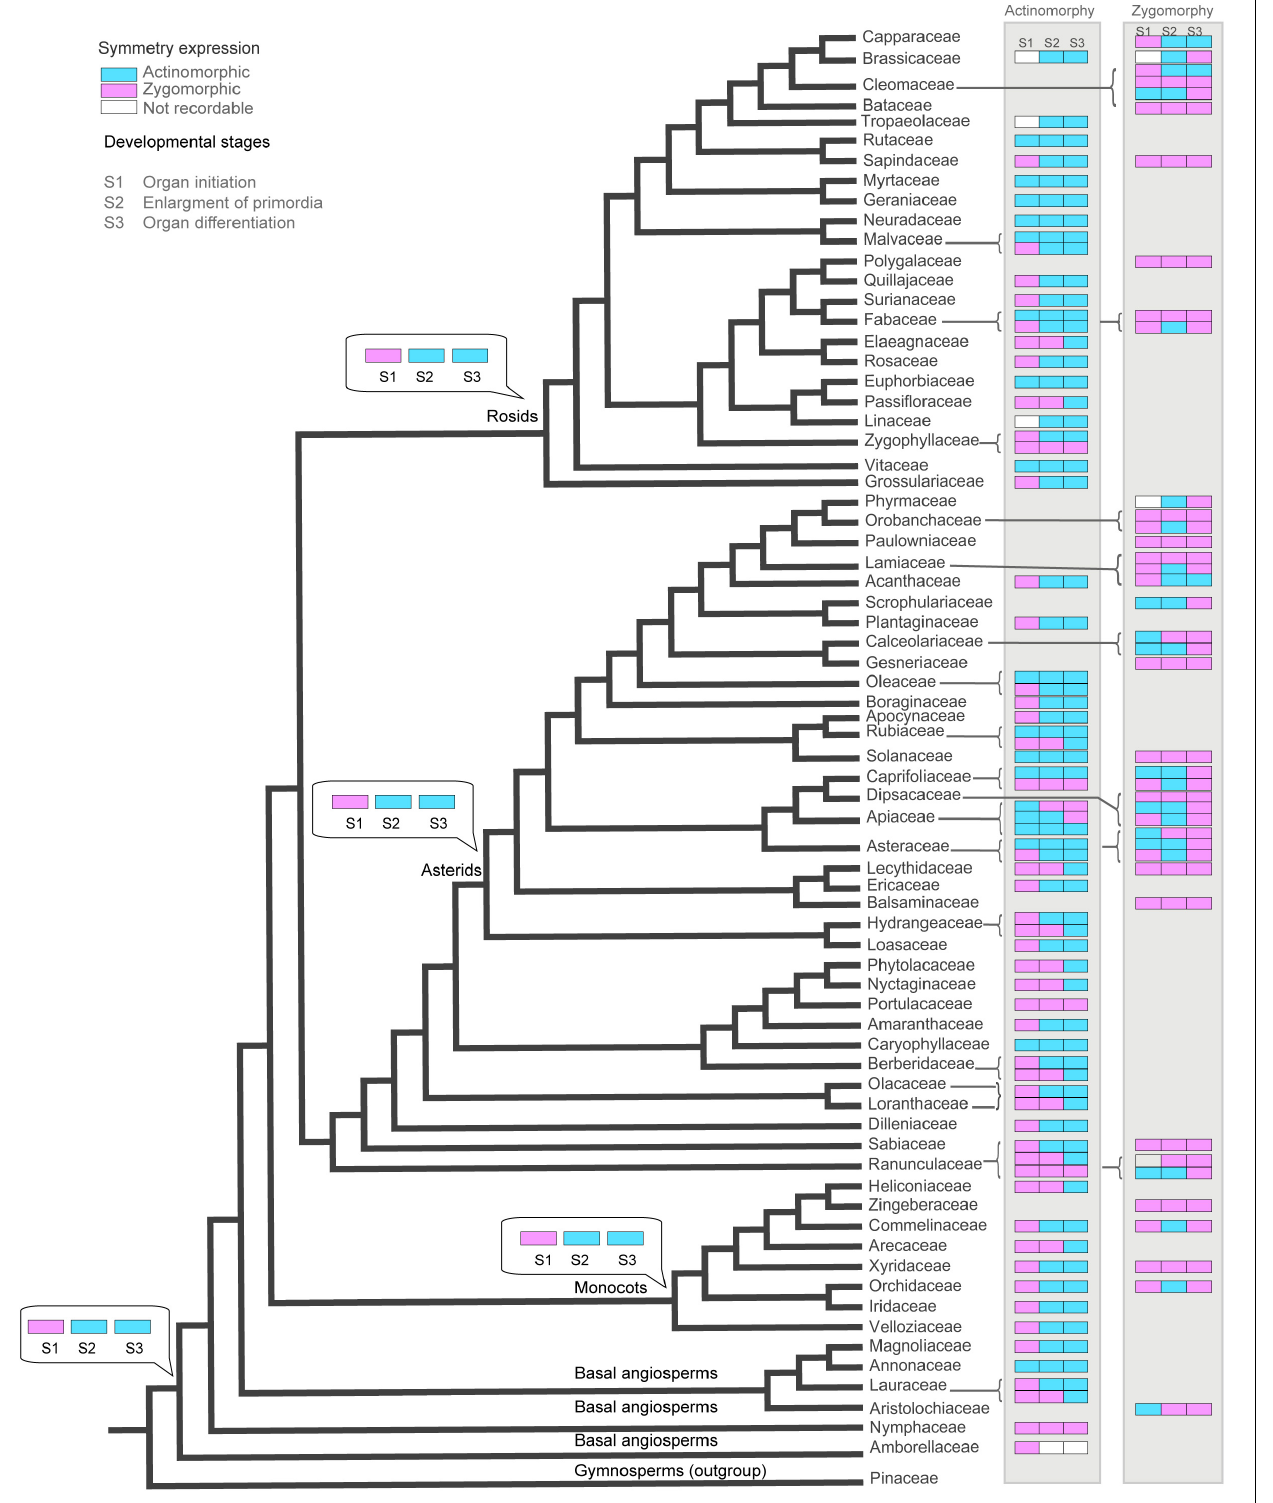
FIGURE 5 | The evolution of corolla symmetry reconstructed on the phylogenetic tree of angiosperms (extracted from Soltis et al., 2011). The ancestral character stats (obtained under Maximum Parsimony method implemented in Mesquite) are shown for the nodes of interest.